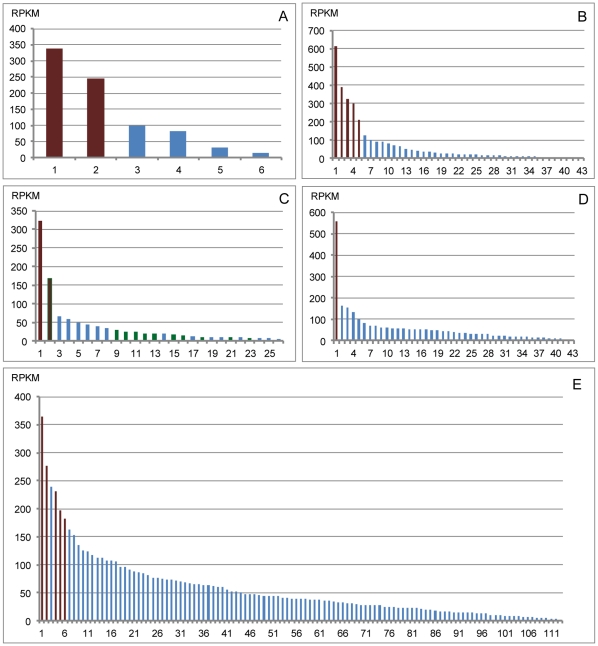
RPKM of putative ELO, FAR and WS genes.A, RPKM of 6 ELO genes; B, RPKM of 43 FAR genes; C, RPKM of 26 enzymes of acyltransferase family, green bars represent the WS genes; D, RPKM of 44 ABC transporters genes; E, RPKM of 113 putative WS genes through BLAST search using bio-cloud computing. Red bars of each histogram represent the genes with the highest RPKM and are selected for qRT-PCR analysis.